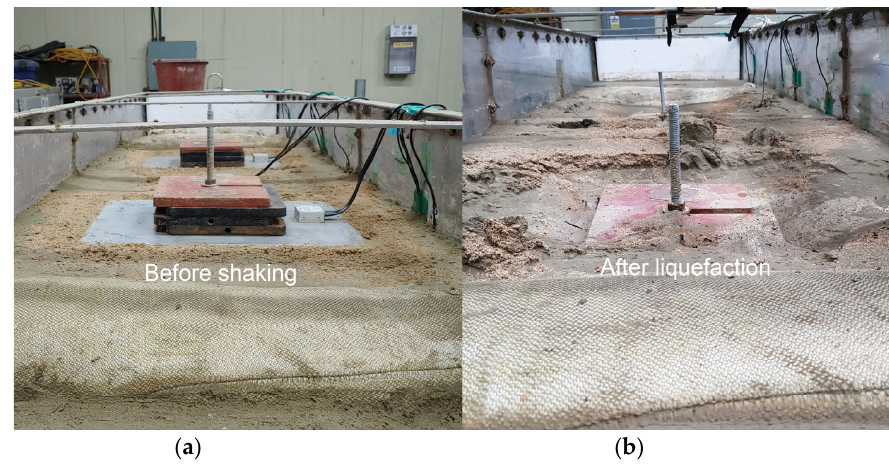
Figure 16. Photo of shallow foundations ( a ) before shaking and ( b ) after shaking.